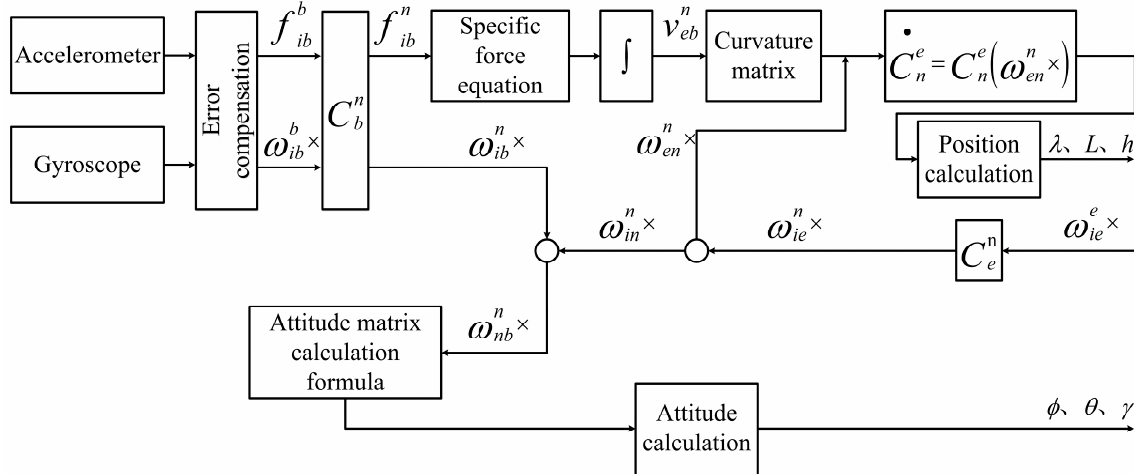
Figure 3. The IMU solution process. Note: 𝐿 is latitude, 𝜆 is longitude, ( ° ); ℎ is altitude, m; 𝛷 , 𝜃 , 𝛾 is pitch angle, heading angle and roll angle, rad; 𝐶 (cid:3029)(cid:3041) (cid:4666)0(cid:4667) is the attitude matrix of spraying robot at initial stage; 𝑓 (cid:3036)(cid:3029) (cid:3029) is the specific force projection of the coordinate system 𝑏 (sprayer coordinate sys- tem) with reference to the coordinate system 𝑖 (geocentric inertial coordinate system) under the coordinate system 𝑏 , m ∙ s (cid:2879)(cid:2870) ; 𝑉 (cid:3032)(cid:3029)(cid:3041) is the velocity projection of the coordinate system 𝑏 with refer- ence to the coordinate system 𝑒 (earth centered earth fixed) under the coordinate system 𝑛 (east- north-sky navigation coordinate system), m ∙ s (cid:2879)(cid:2869) ; 𝐶 is the directional cosine matrix, 𝜔 is the angu- lar velocity, rad ∙ s (cid:2879)(cid:2869) , the upper comer indicates the coordinate system of the variable, the lower comer indicates the transformation coordinate system.